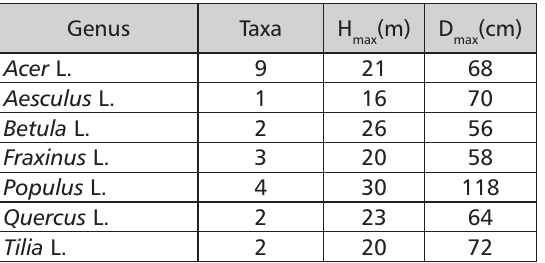
Composition of the highest and thickest broadleaves by genus